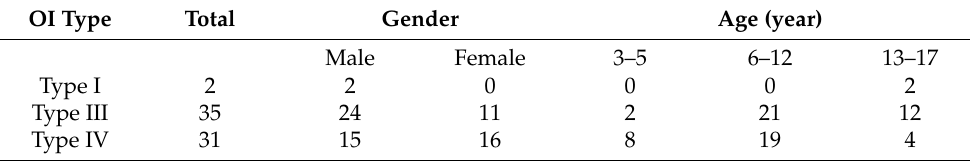
Table 1. Gender and age distribution in each OI